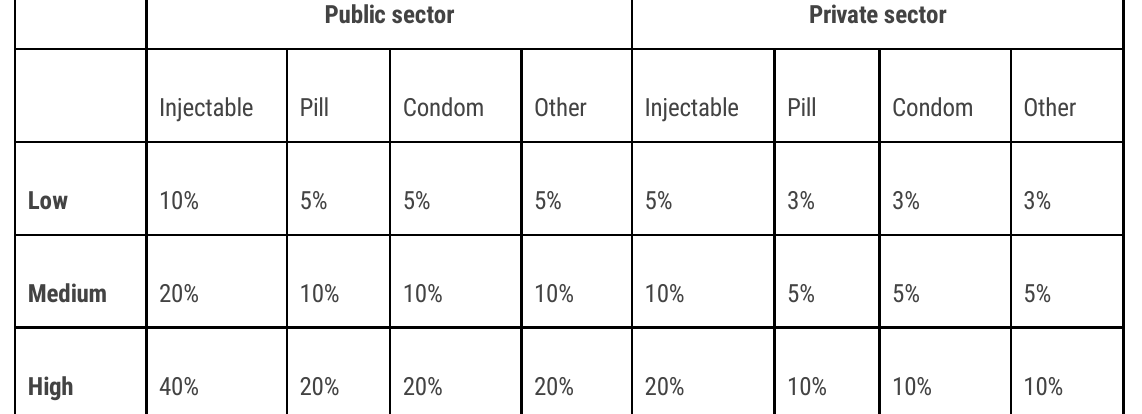
Public sector Private sector